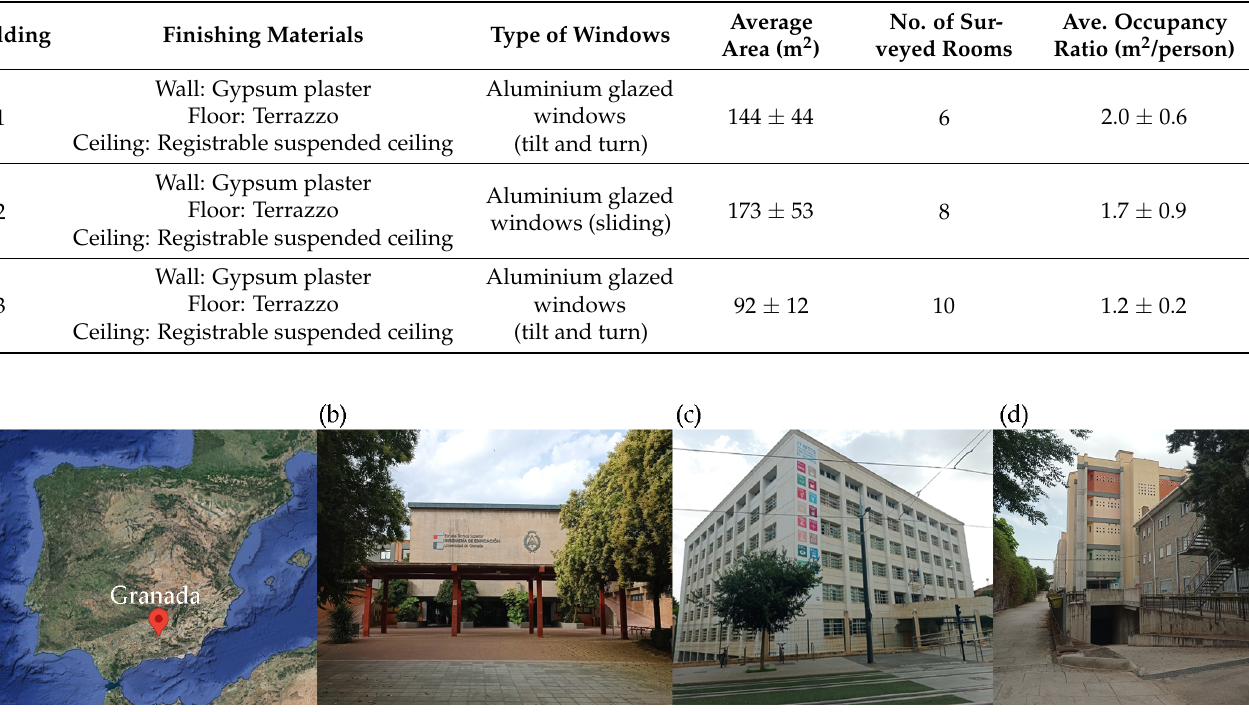
Figure 2. ( a ) Investigated buildings’ location. ( b ) Building 1. ( c ) Building 2. ( d ) Building 3.